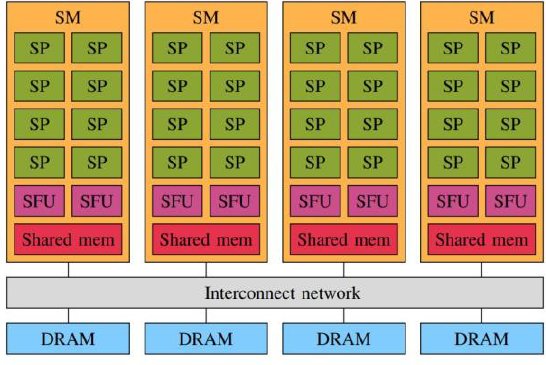
Fig. 4. GPU Architecture, reproduced from [10]